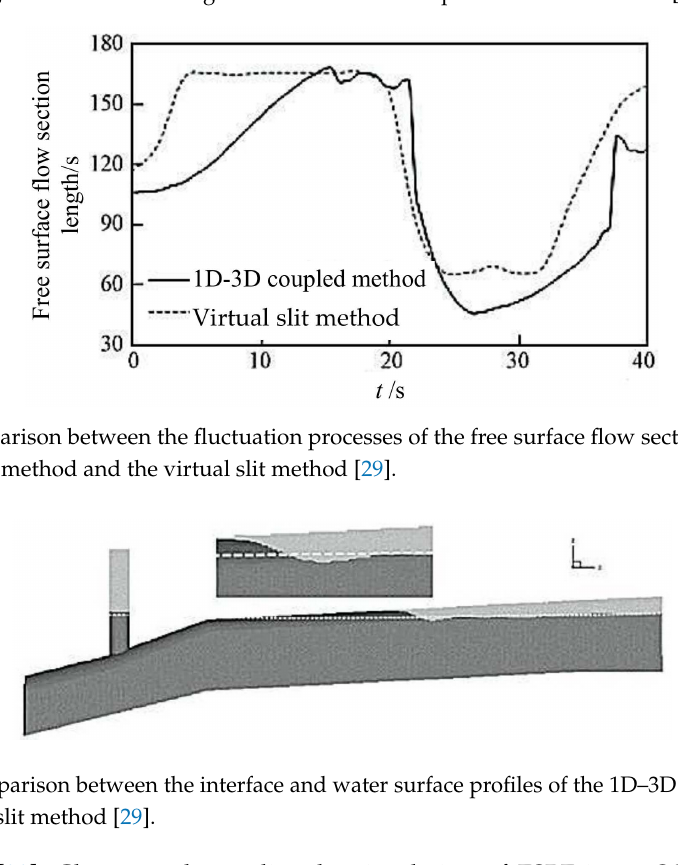
Figure 8. Schematic diagram for the 1D–3D coupled simulation model [29].